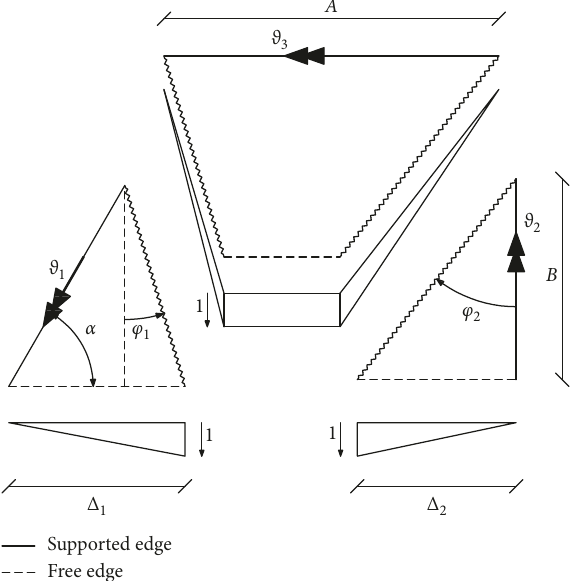
Supported edge Figure 2: Virtual displacements of the slab